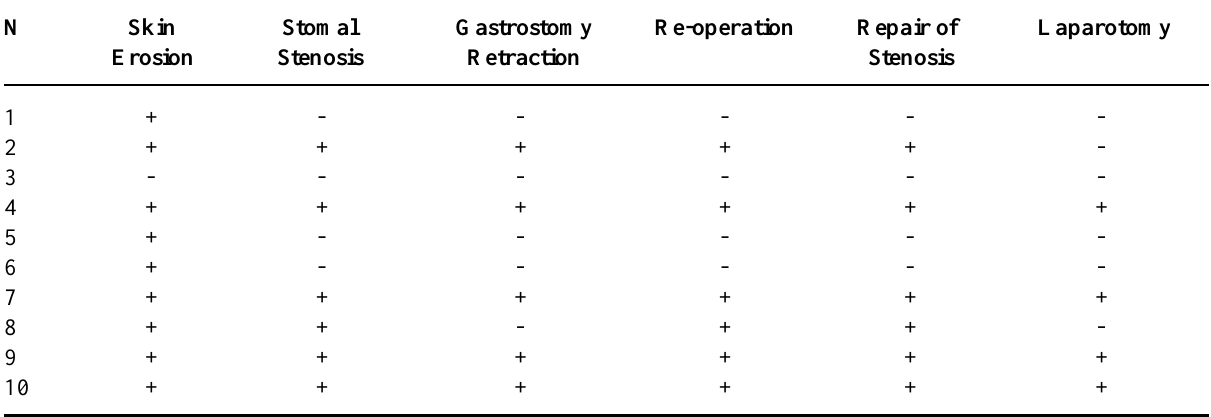
Table 2 – Complications in the control group.